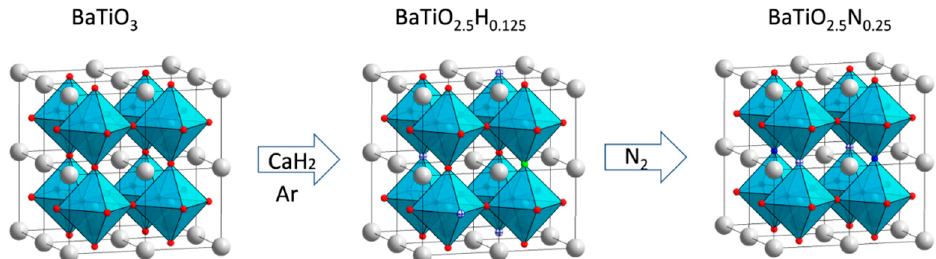
Figure 1. Sketch of material conversions: hydride reduction of BaTiO 3 leading to an O-deficient oxyhydride (exemplified as H/vacancy disordered BaTiO 2.5 H 0.125 ) which then is nitridized with elemental nitrogen (exemplified as BaTiO 2.5 N 0.25 with an ordered (orthorhombic) N/vacancy arrangement). Ba, O, H, N and vacancies are depicted as grey, red, green, blue, and white-blue circles, respectively.